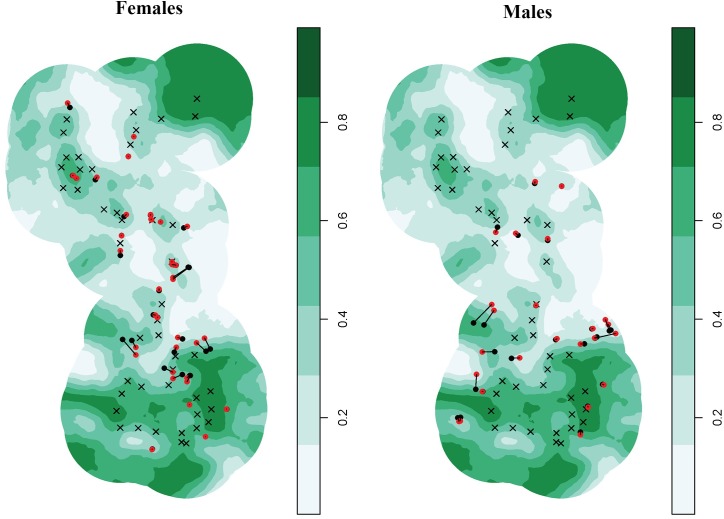
Sex-specific posterior modes of activity centers estimated by spatially inhomogeneous and homogenous density spatial capture-recapture models relative to percent natural cover for Florida black bears in the Highlands-Glades subpopulation of south-central Florida, USA (2010–2012).Posterior modes from inhomogeneous (varies by percent natural cover) and homogenous density models are indicated by red and black circles, respectively. Locational shifts for each posterior mode between models are denoted by solid black lines, and crosses (×) represent the 46 hair traps that were established. Locations where only a red circle is visible without a solid black connector line indicates a black circle is at the same location. Percent natural cover within the state space is the background color gradient from white (low %) to dark green (high %).